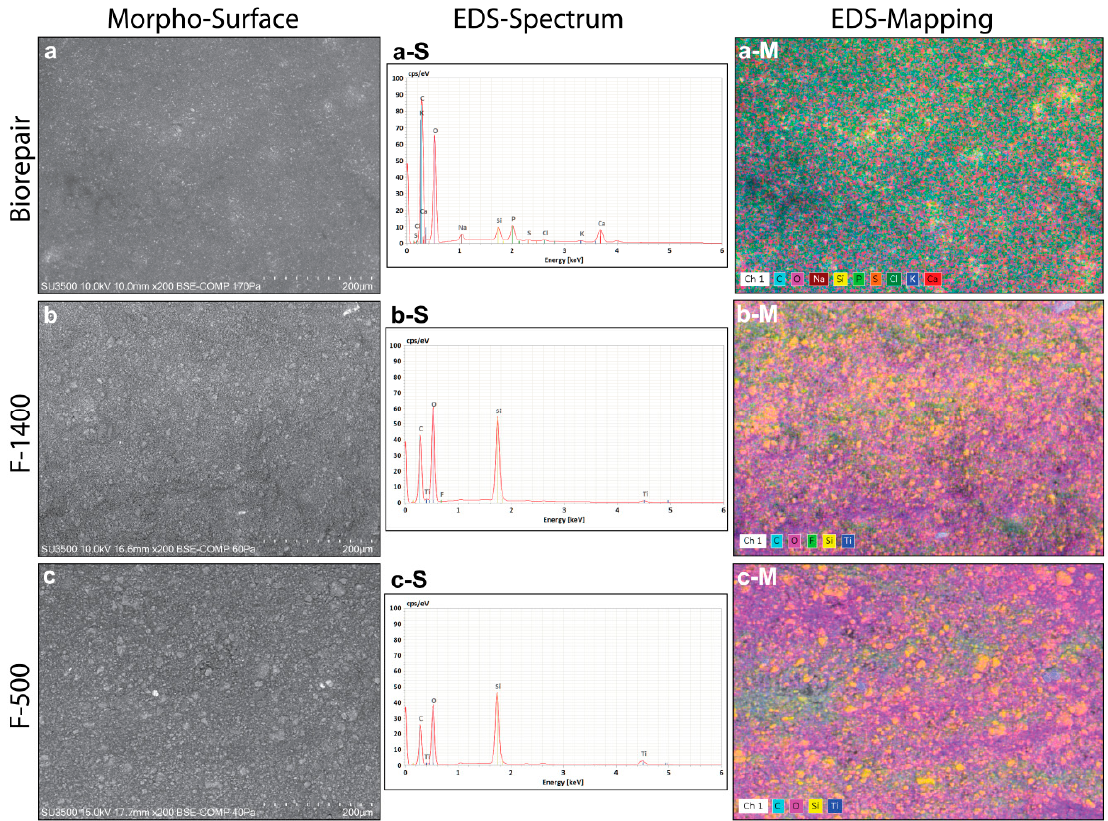
Figure 2. Morpho-chemical analysis of hydrated Biorepair, F1400, and F500 biomaterial toothpastes. ( a–c ) VP-SEM images illustrating the surface morphology. ( a-S , b-S and c-S ) EDS spectra probed on the